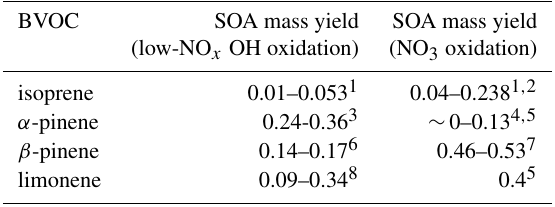
Table 1. Overview of SOA mass yields from previous chamber ex- periments on isoprene, α -pinene, β -pinene, and limonene. BVOC SOA mass yield SOA mass